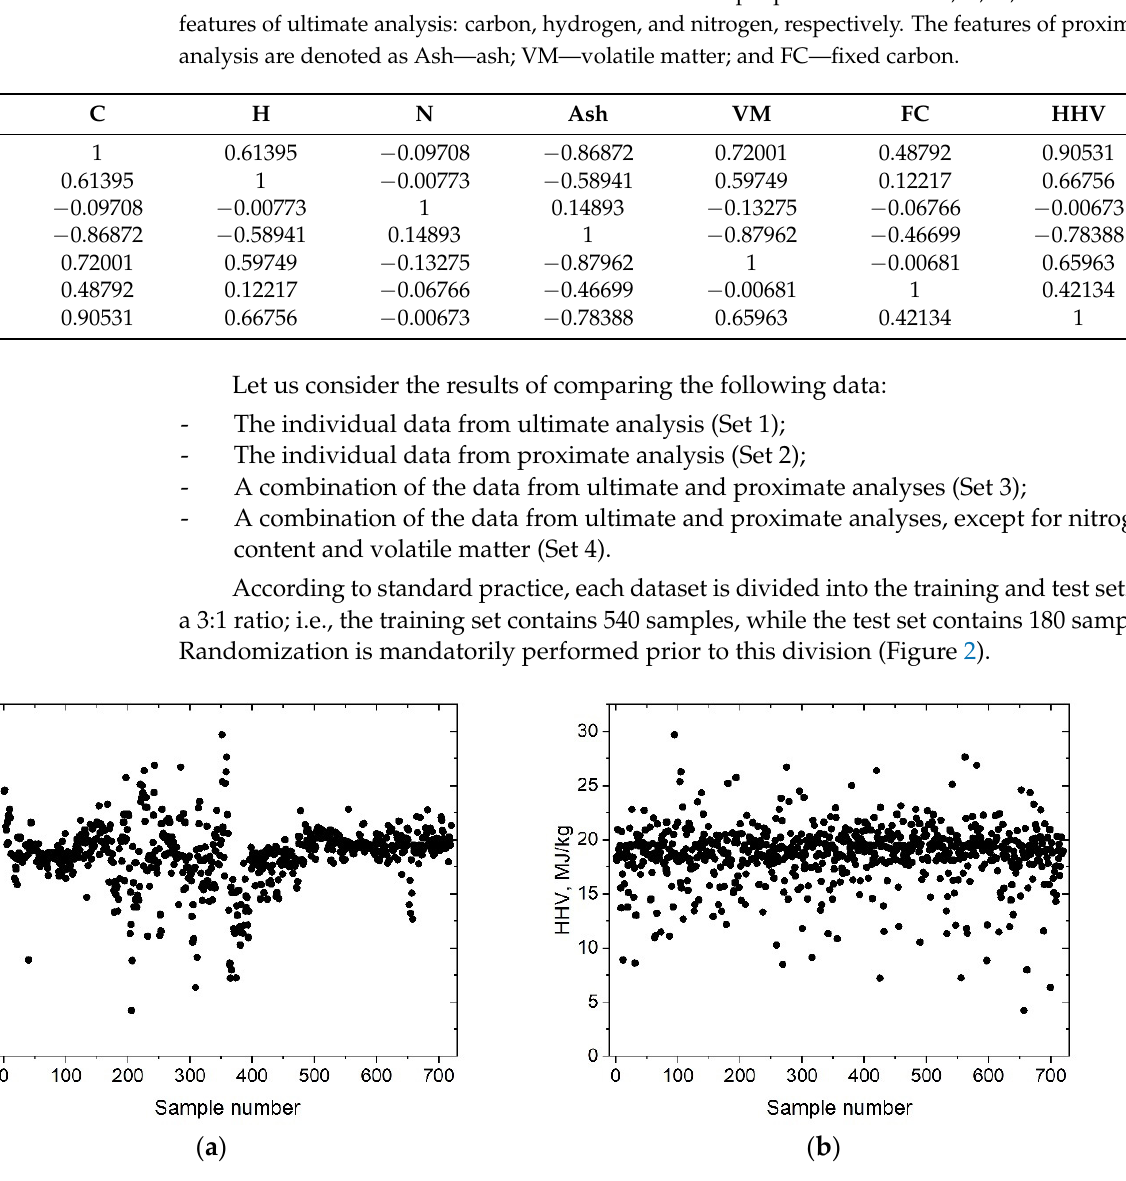
( c ) Figure 3. The initial ( a ), normalized ( b ), and centralized ( c ) values of training sample parameters.